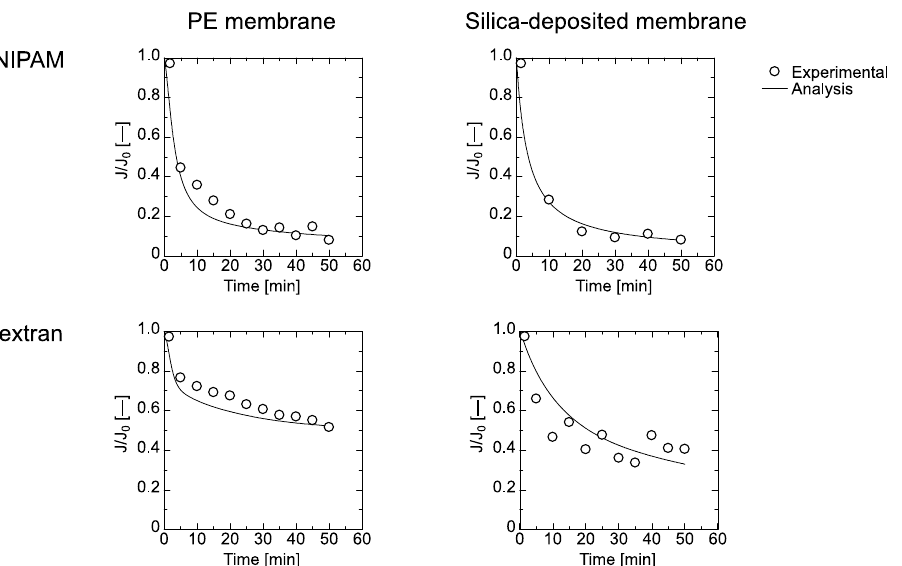
Figure 4. Flux time course curves of PNIPAM gel and dextran solutions through PE and silica- deposited membranes.